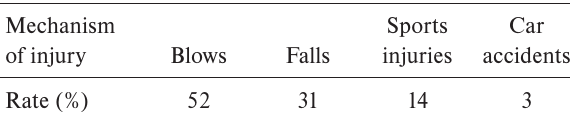
Table 1. Mechanism of injury.